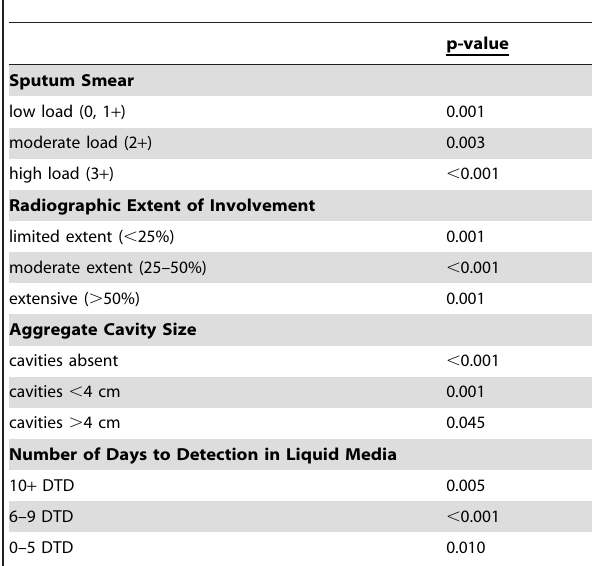
Table 2. Wilcoxon test P-values for the probability of sputum culture conversion in liquid media comparing African and non-African patients with equivalent baseline measures of disease severity during the first eight weeks of tuberculosis therapy as shown in figures 2, 3, 4, 5, TBTC Study